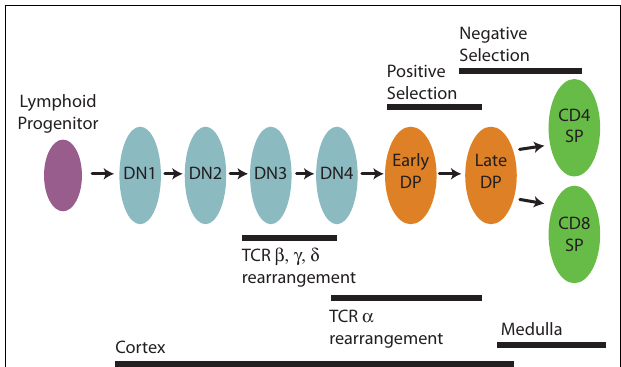
FIGURE 1 | Stages in the development of CD4 and CD8T cells in the thymus